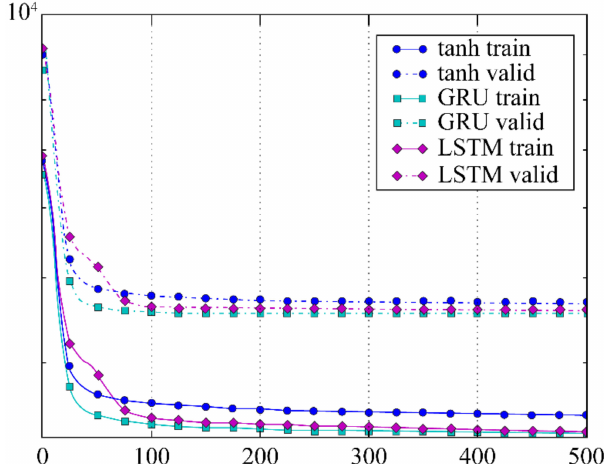
Figure 9. Learning curves for the training and validation sets of different types of units with respect to the number of iterations. The x-axis corresponds to the number of epochs, and the y-axis corresponds to the negative log likelihood of the learning probability distribution over sequences in the log scale (Source: